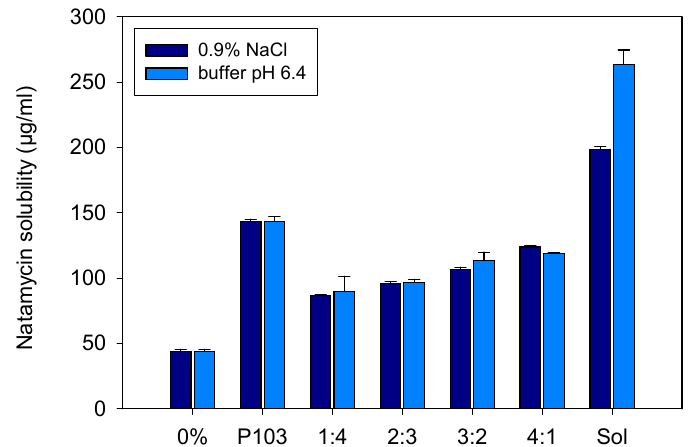
Figure 3. Apparent solubility of natamycin in micelle dispersions of 10% ( w / v ) of Soluplus and Pluronic P103 and their mixtures (Soluplus:Pluronic P103) prepared at various volume ratios in 0.9% NaCl and pH 6.4 buffer. Total copolymer concentration was 10% w / v in all cases.